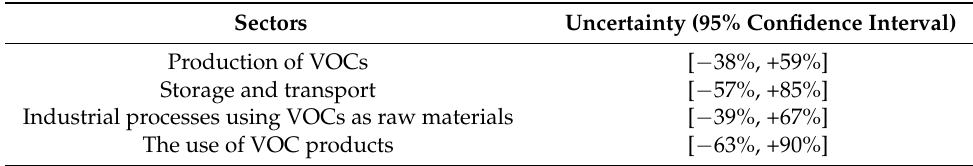
Table 7. The estimated uncertainty range of industrial VOC emissions for each sector in 2015. Sectors Production of